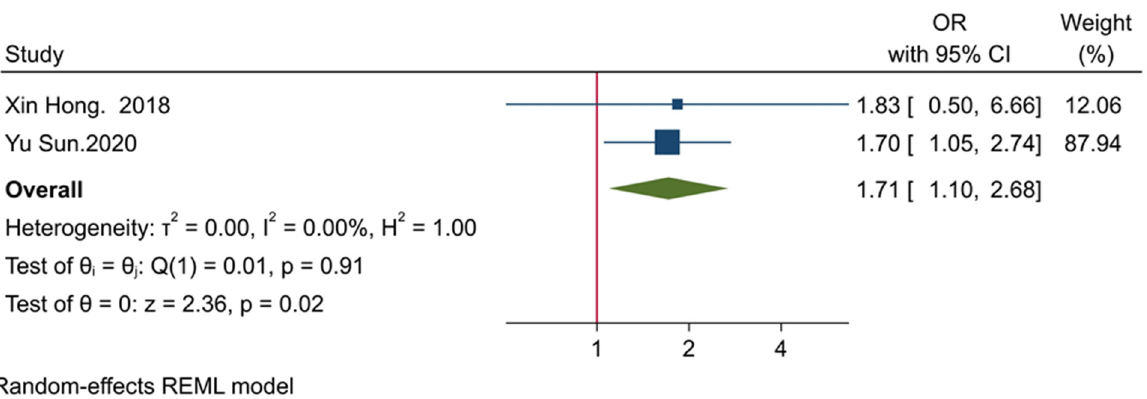
Figure 3. Forest plot for evaluating the association between the expression of TIGIT and PD-1.